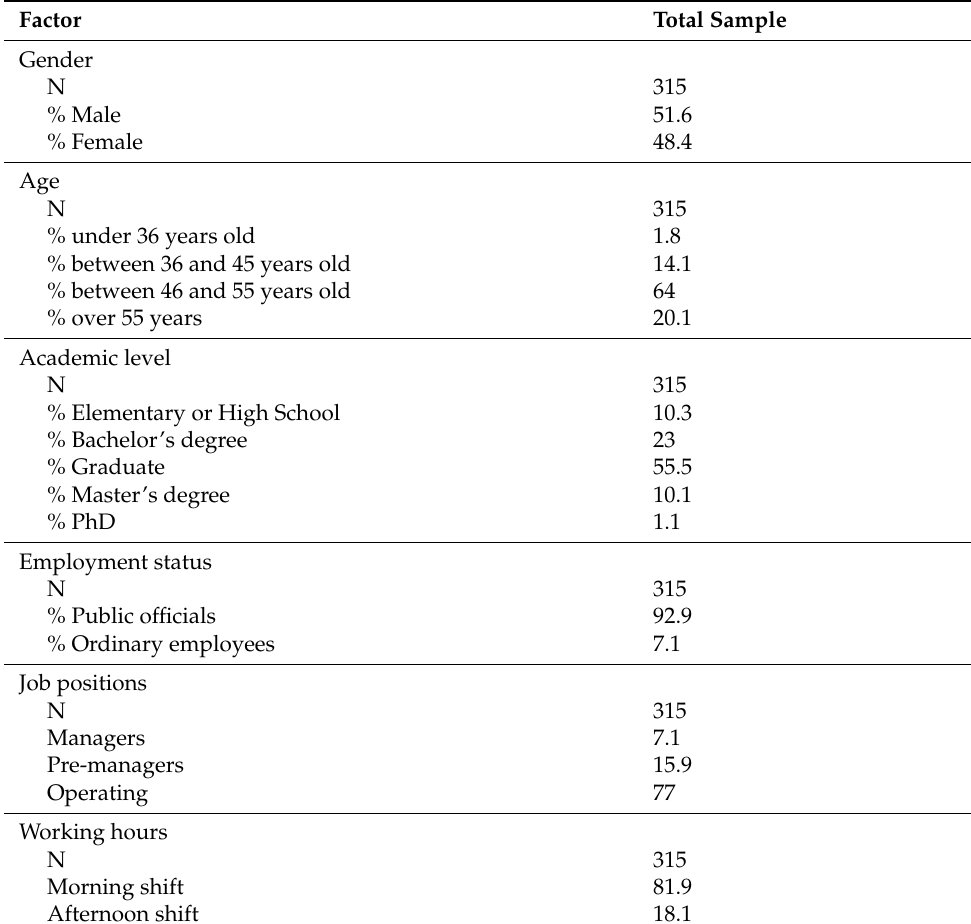
Table 1. Demographic data of the